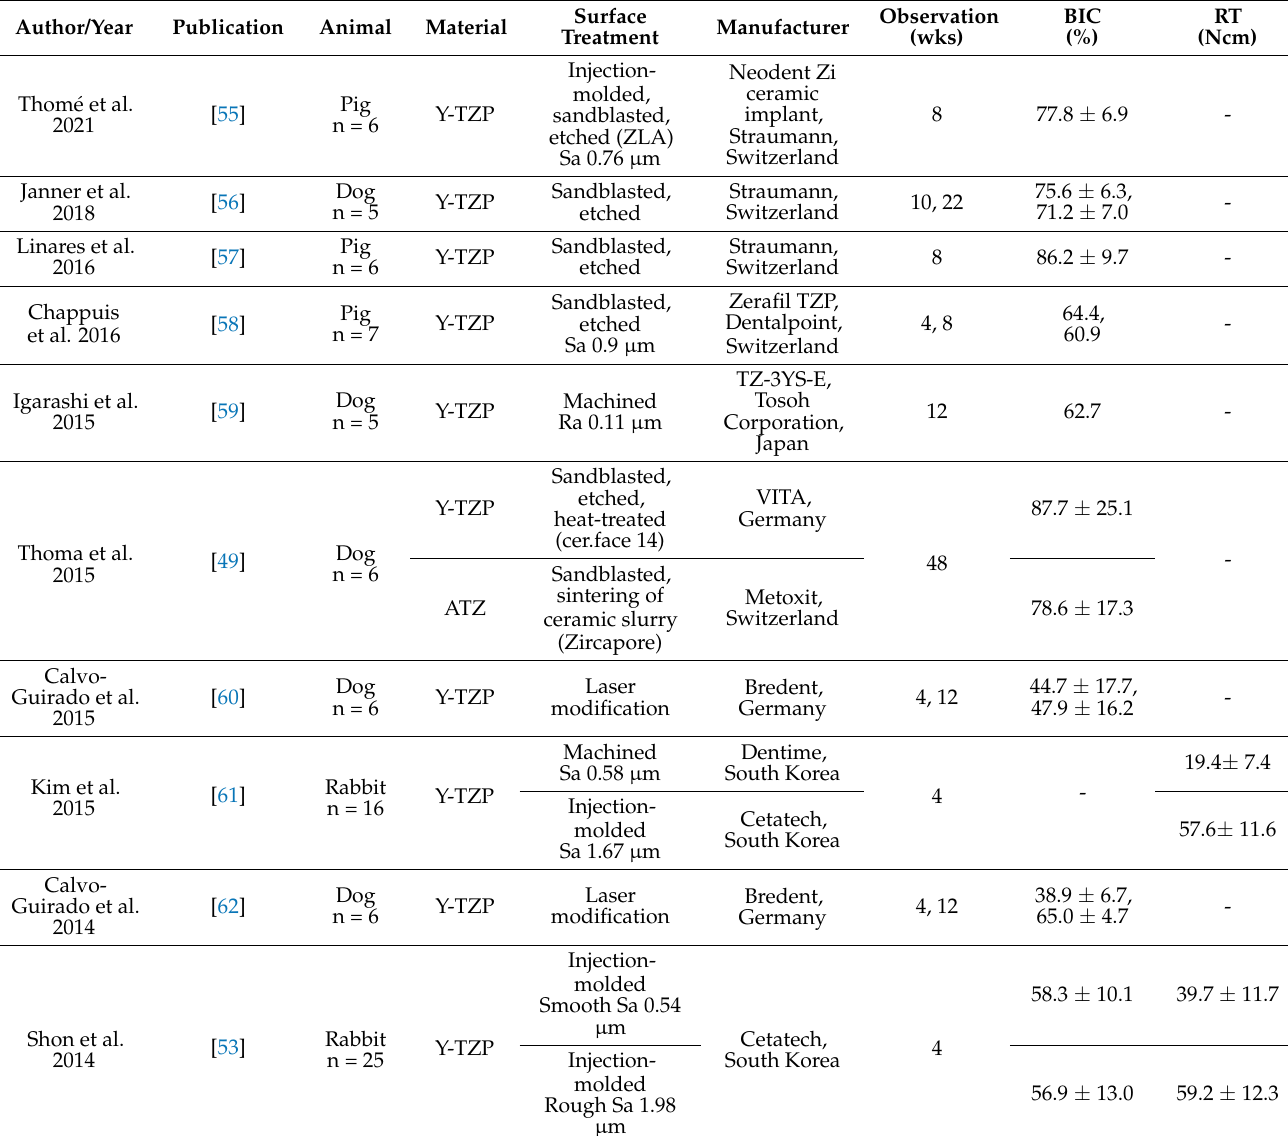
Table 2. Overview of preclinical studies that measured bone-to-implant contact or removal torque (mean with standard deviations) of zirconia